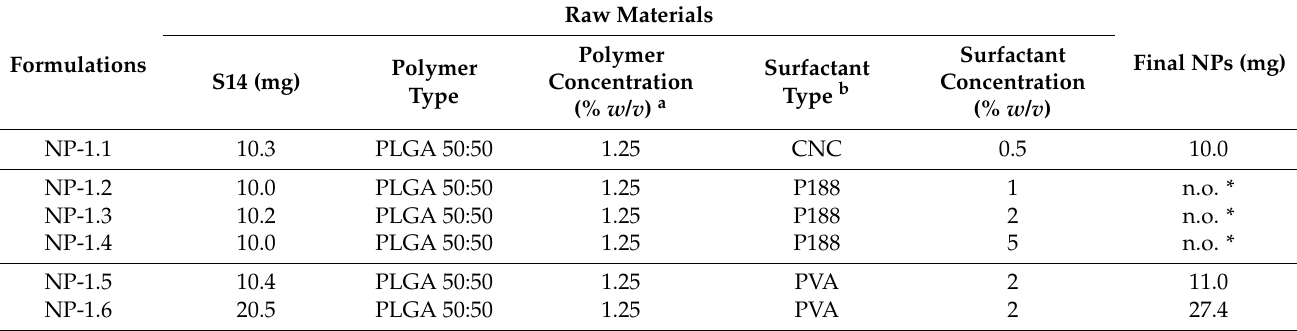
Table 1. Composition of the different PLGA nanoparticles prepared using the single-emulsion method.